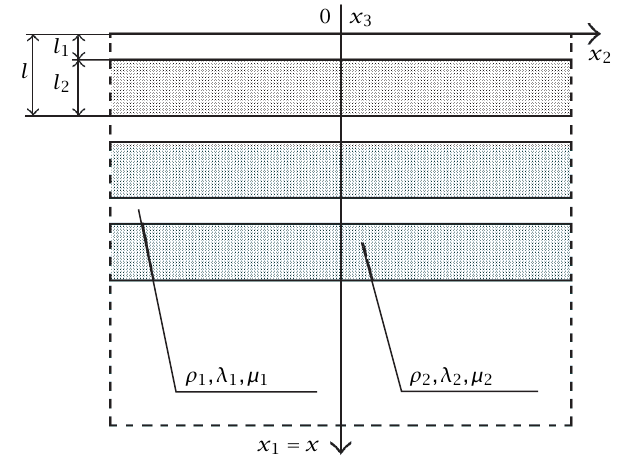
Figure 1.1 . Configuration of a microperiodic layered elastic